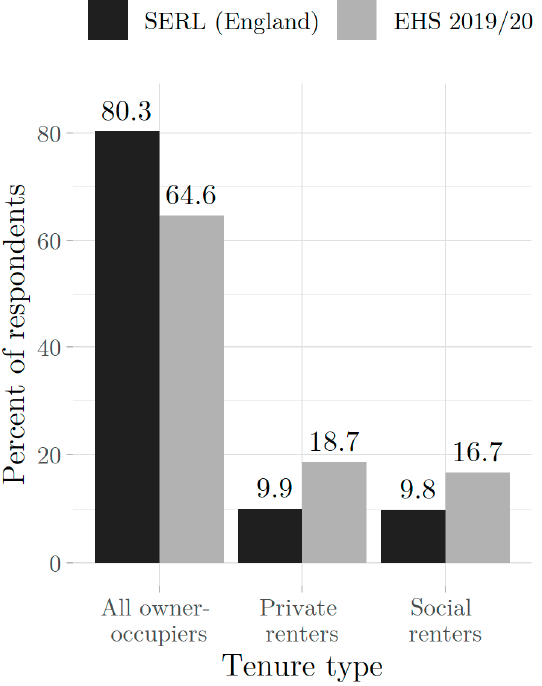
Figure 10. Comparing SERL Observatory tenure types in England (counts rounded down to the nearest 20 for statistical disclosure control) with the EHS 2019/20 survey (question B4).